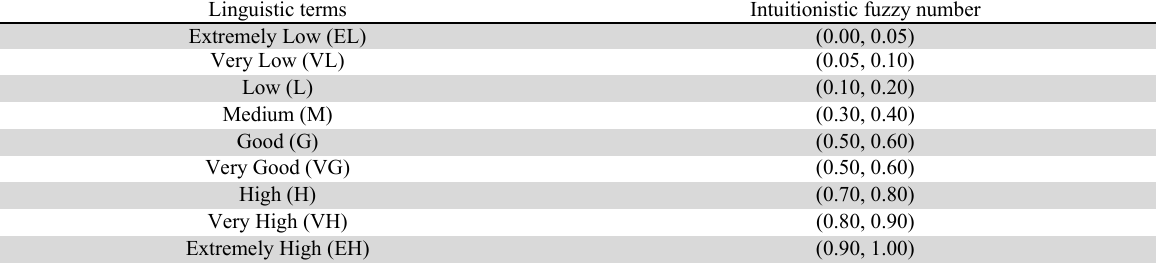
Fuzzy numbers for approximating the linguistic